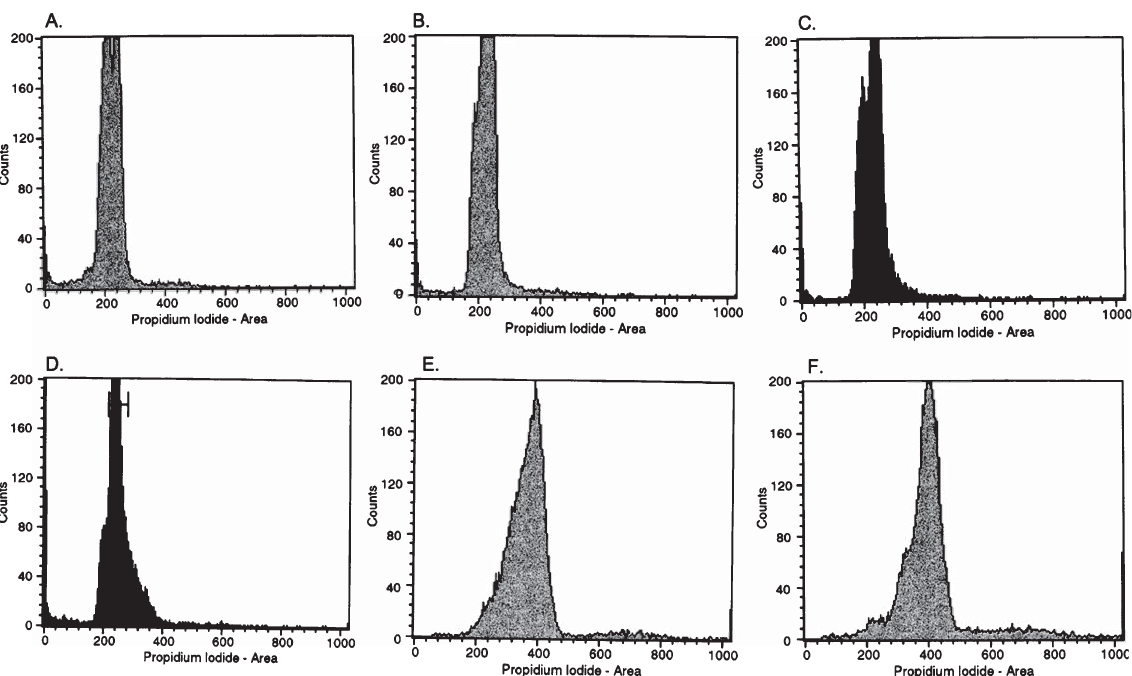
Fig. 1. FACS DNA profiles of cells separated using centrifugal elutriation. Proliferating, asynchronous MOLT-4 cells were separated using centrifugal elutriation into fractions that corresponded to cells in different phases of the cell cycle, and stained for DNA content using propidium iodide. A. Fraction 2, all cells are in early G1. B. Fraction 3, cells range from early to mid G1. C. Fraction 4, cells range from mid-G1 to late G1. D. Fraction 5, cells are at the G1/S boundary (late G1 – early S phase). E. Fraction 6, cells are in mid to late S phase. F. Fraction 7, cells are in